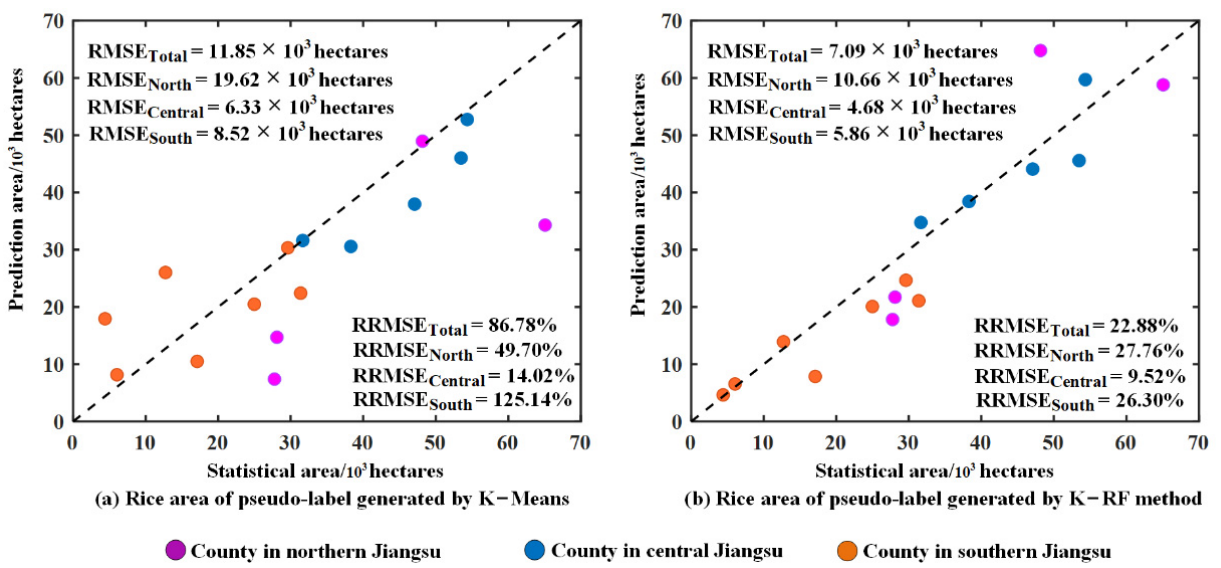
Figure 7. The county-level comparison of rice area between statistics data and pseudo-labels; ( a ) and ( b ) are the rice area of pseudo-labels generated by K-means algorithm and K–RF method, respec-tively.